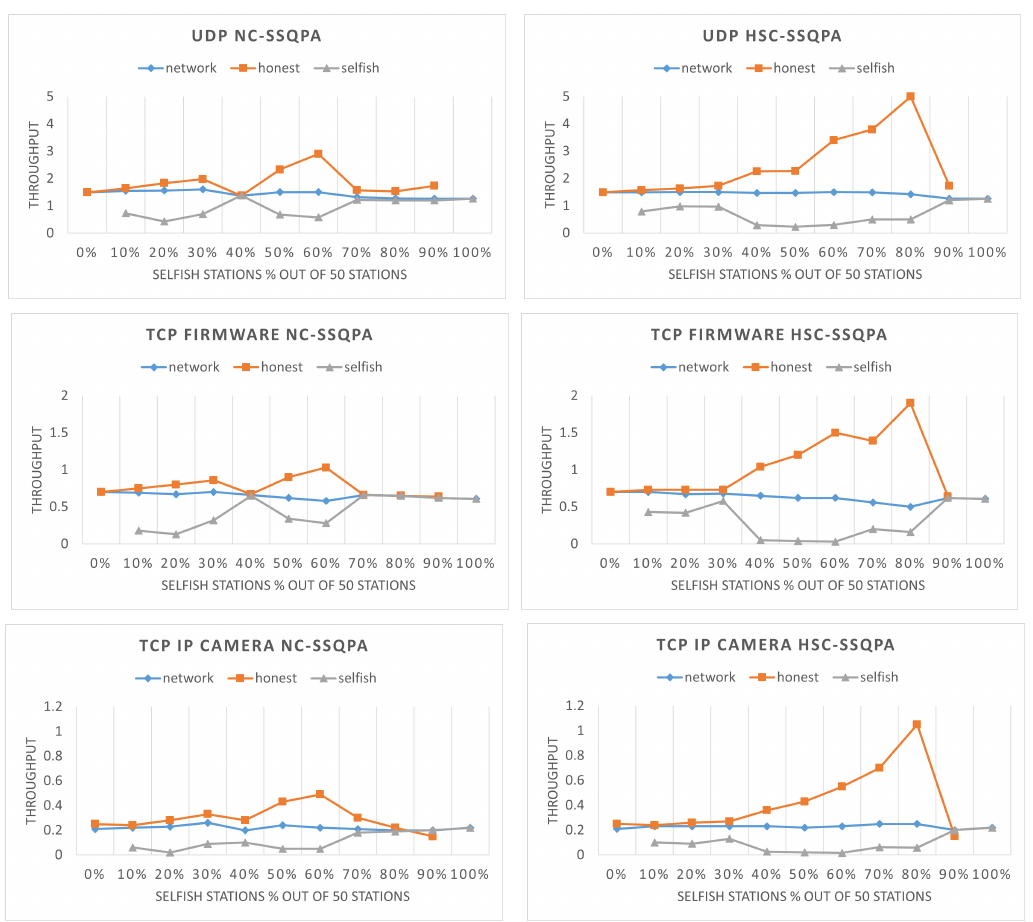
Figure 13. Network throughput (in Mbps) comparison of selfish and honest stations in both variants of SSQPA: ( left ) NC-SSQPA, ( right )